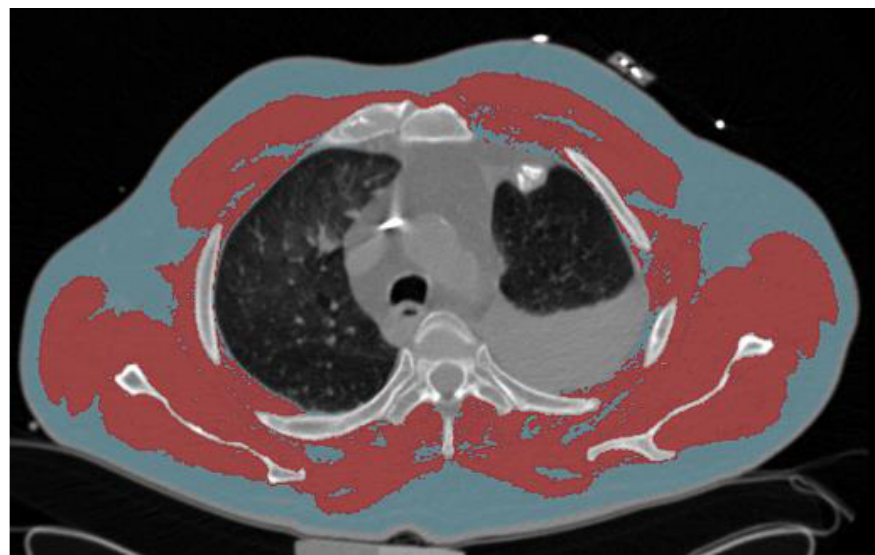
Figure 1. Segmentation at L3. Yellow: L3 visceral adipose tissue; red: L3 skeletal muscle tissue; blue : L3 subcutaneous adipose tissue